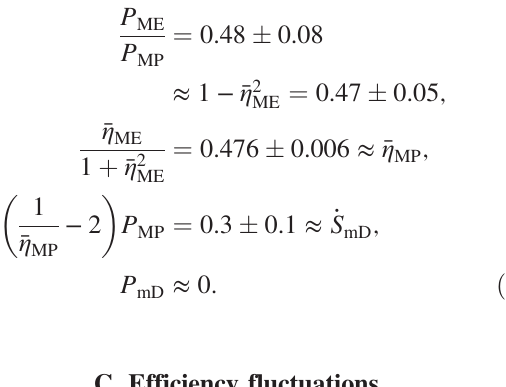
ffiffiffi p 5 k T= μ m. Following Eq. (44), the efficiency is B